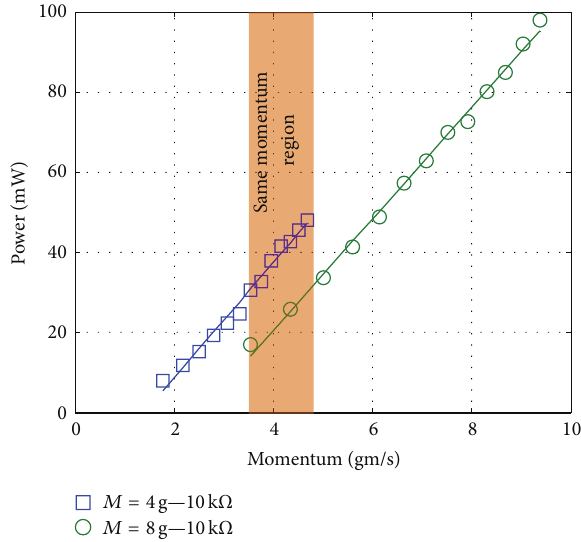
Figure 4: Average output power (2ms) versus velocity.